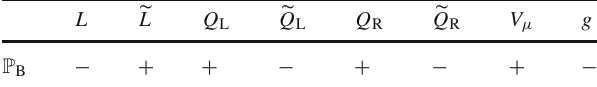
Table 3 P B parity charges of the SHUT fields. Scalarfields are denoted with tildes, V μ corresponds to vector bosons while g are the gaugino